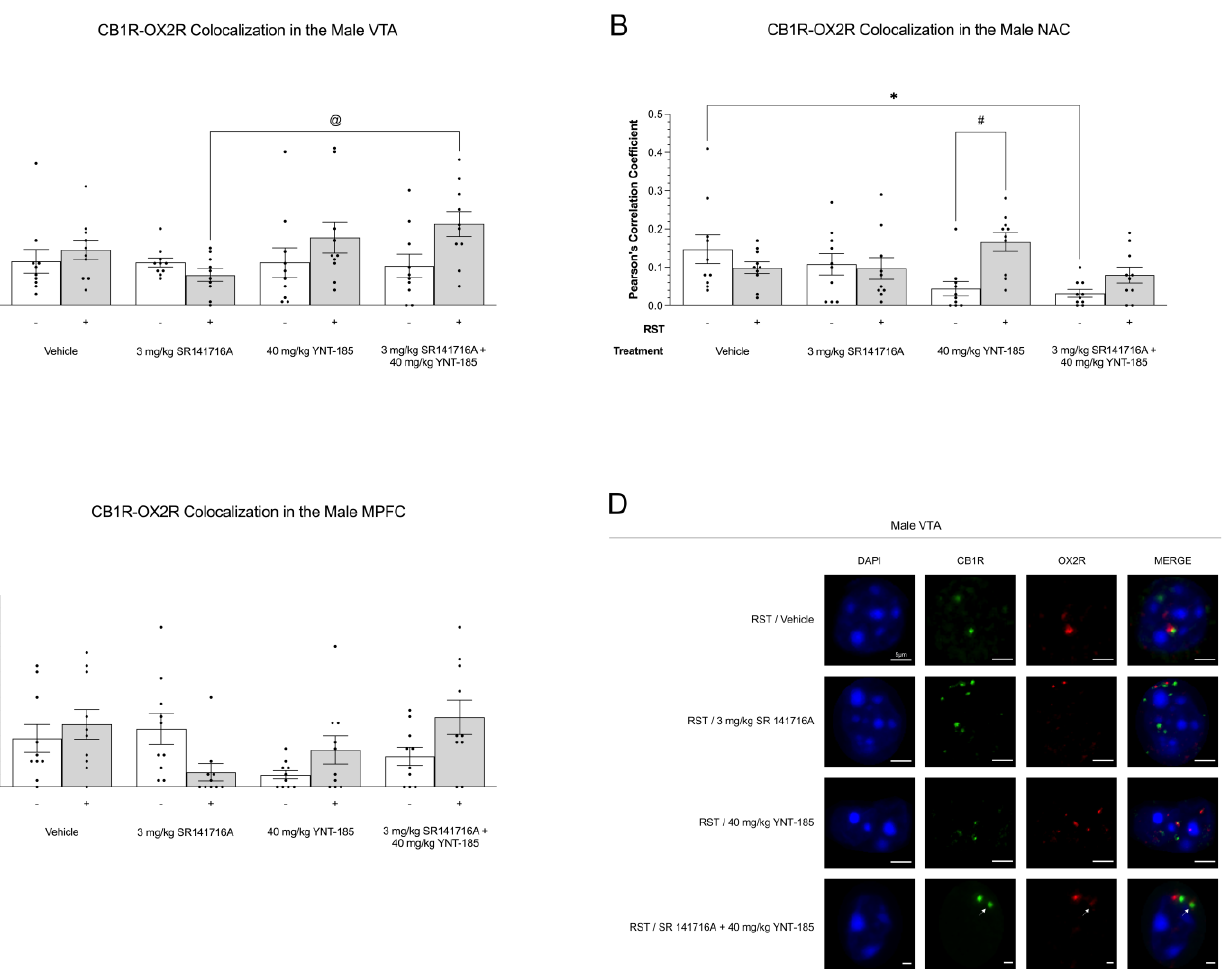
Figure 6. Cannabinoid receptor type 1 and OX2R colocalization in mesocorticolimbic brain regions of male mice that had undergone 24 h RST and drug treatments. ( A – C ), CB1R-OX2R colocalization in the VTA ( A , D ), NAC ( B , E ), and MPFC ( C , F ) of 200 µL vehicle, 3 mg/kg SR141716A, 40 mg/kg YNT-185, and 3 mg/kg SR141716A + 40 mg/kg YNT-185-treated adult male C57BL/6 mice.